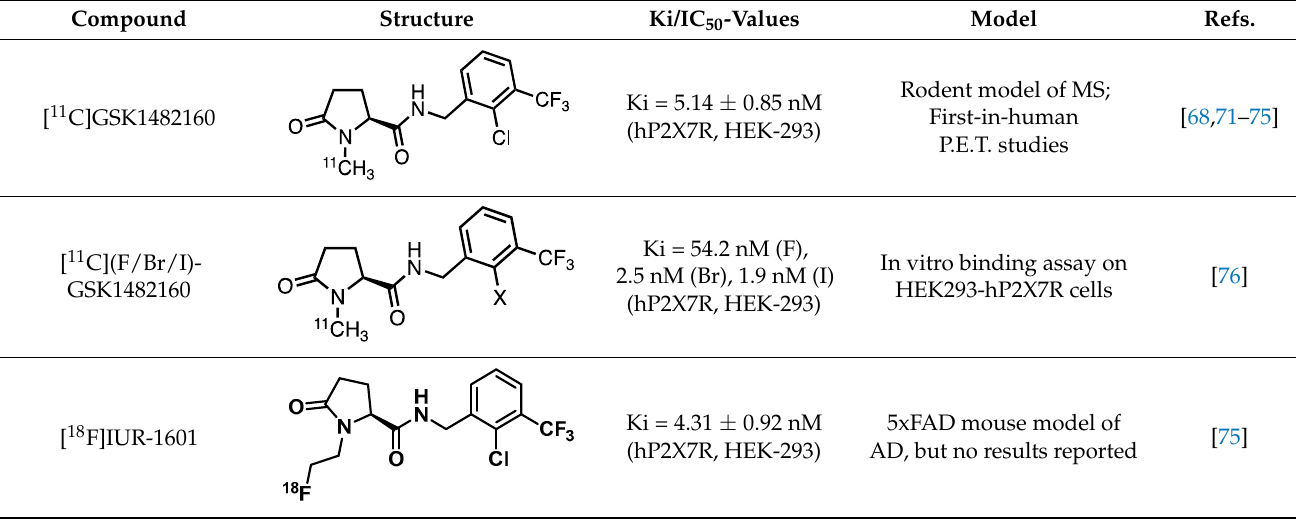
Table 1. P2X7R PET tracers. Structure